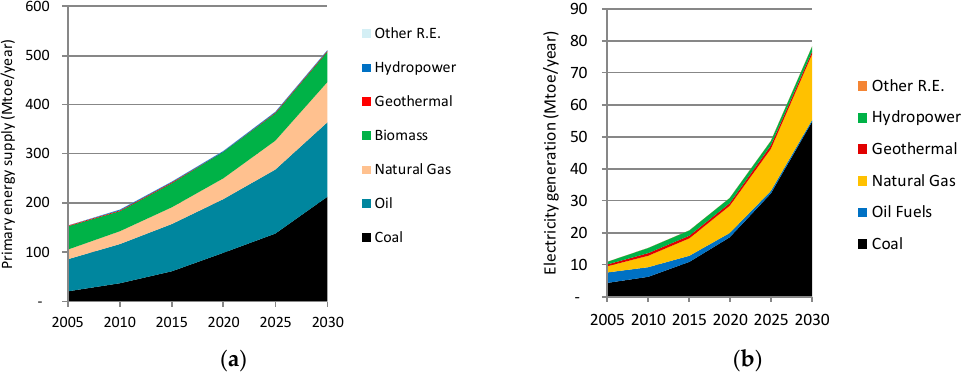
Figure 5. Primary energy supply and electricity generation projections under the baseline scenario. ( a ) Primary energy supply; and ( b ) power generation.